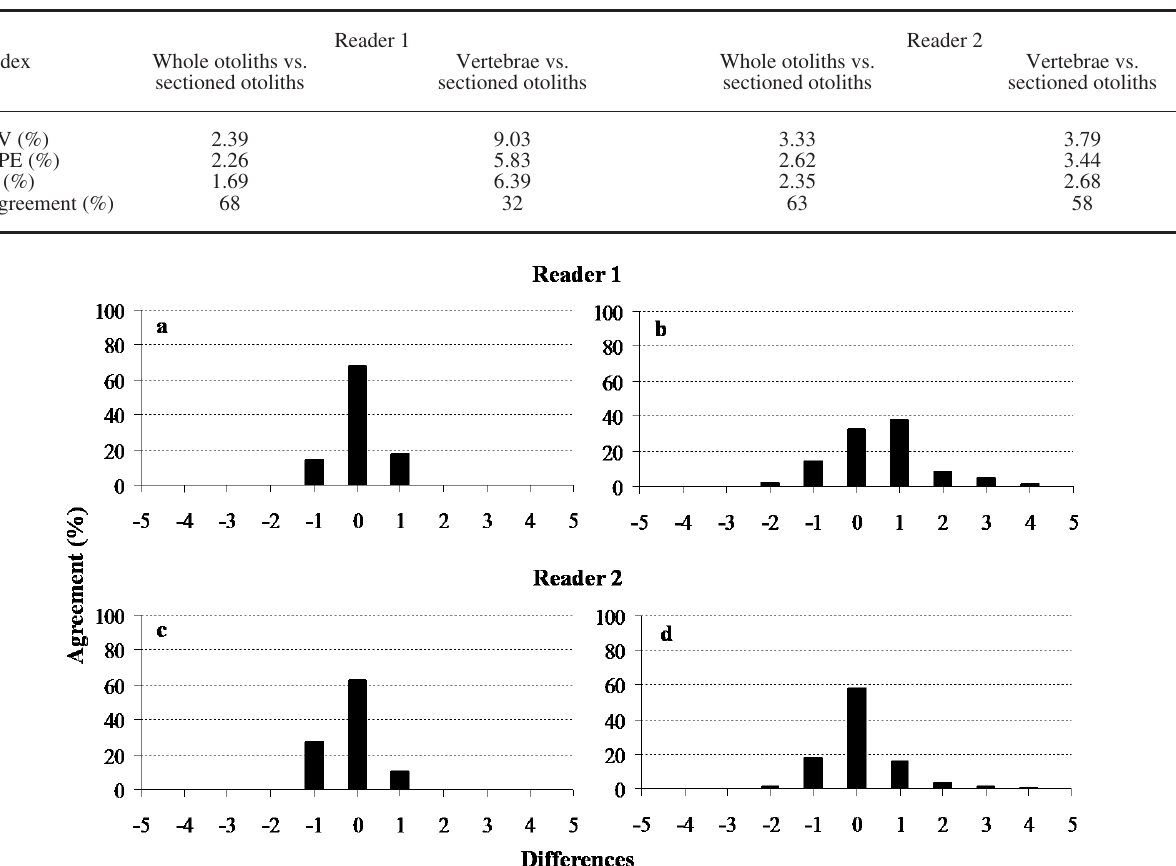
Table 3. – Measures of precision for age readings on Aphanopus carbo between ageing preparation methods.